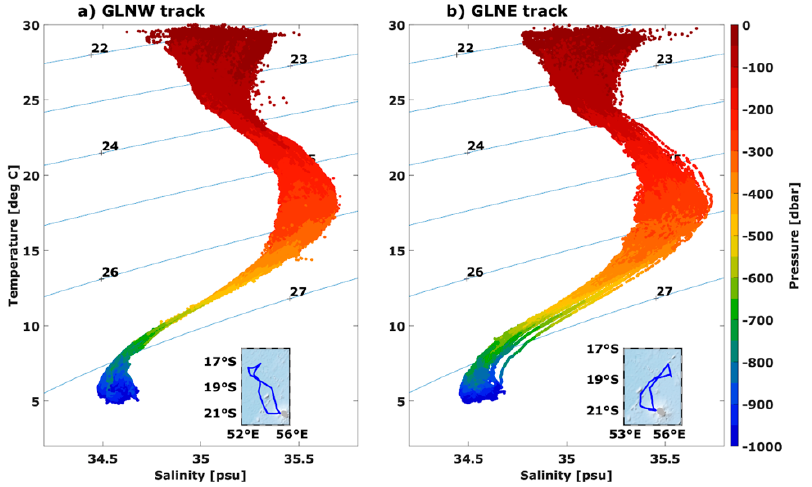
Figure 14. Temperature–salinity (TS) diagram along ( a ) GLNW and ( b ) GLNE tracks from 23 January to 23 March 2019. Inserts show corresponding glider tracks.